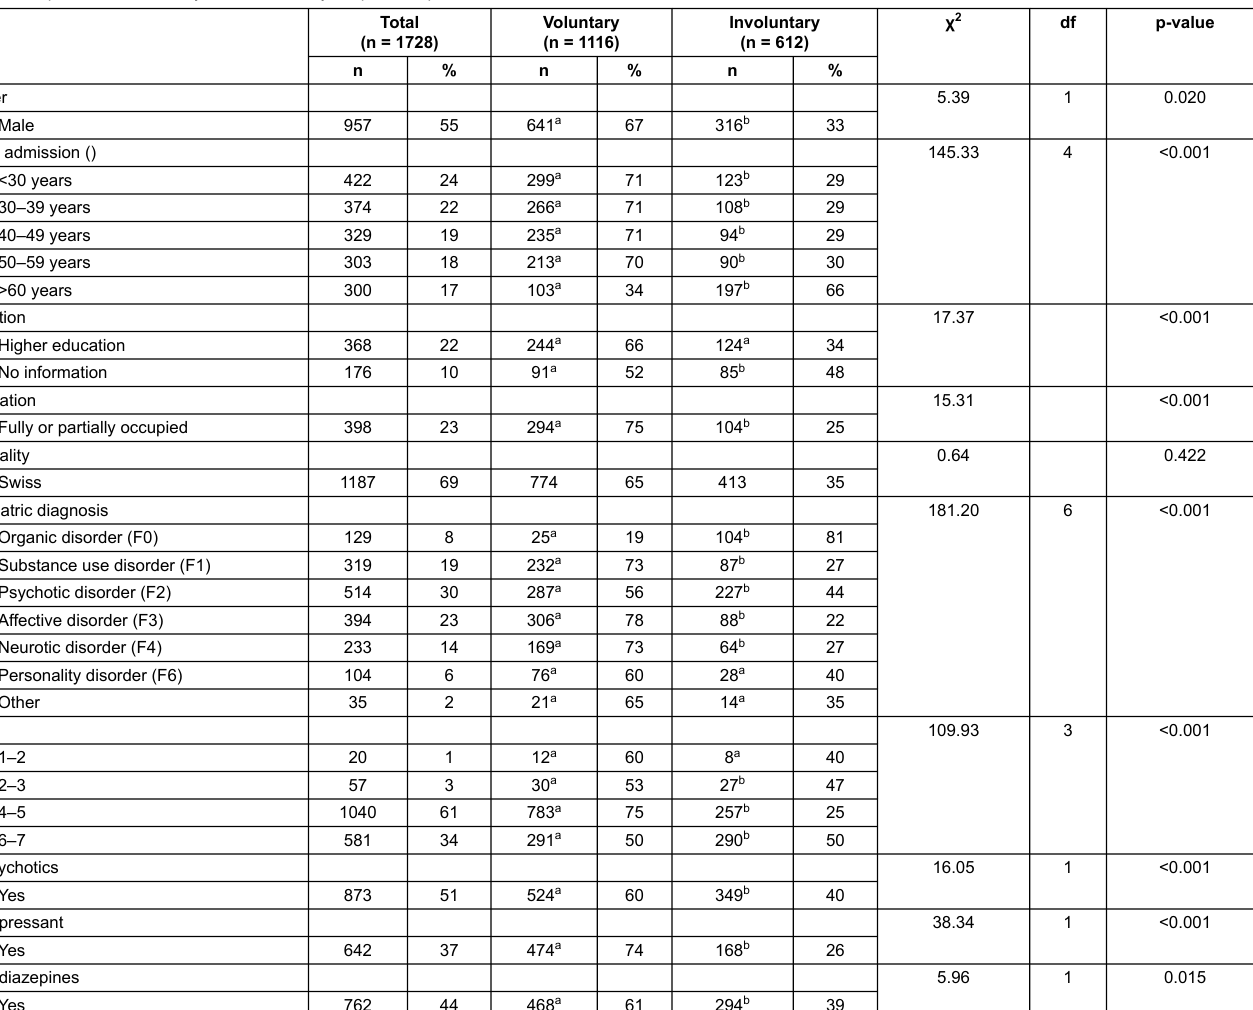
Table 1: Comparison of voluntarily and involuntarily hospitalised